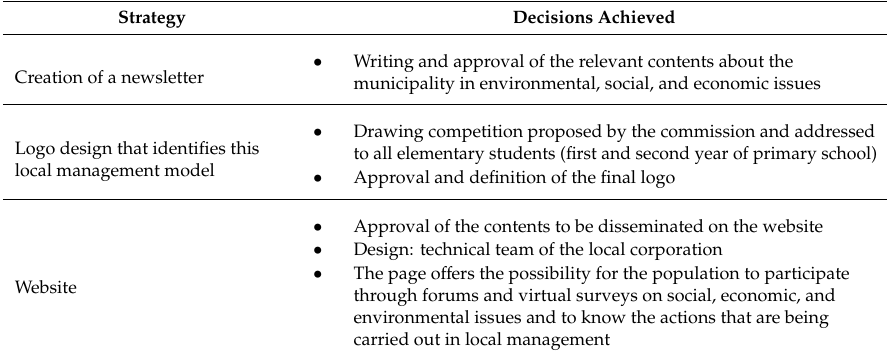
Table 8. Decisions achieved by the monitoring